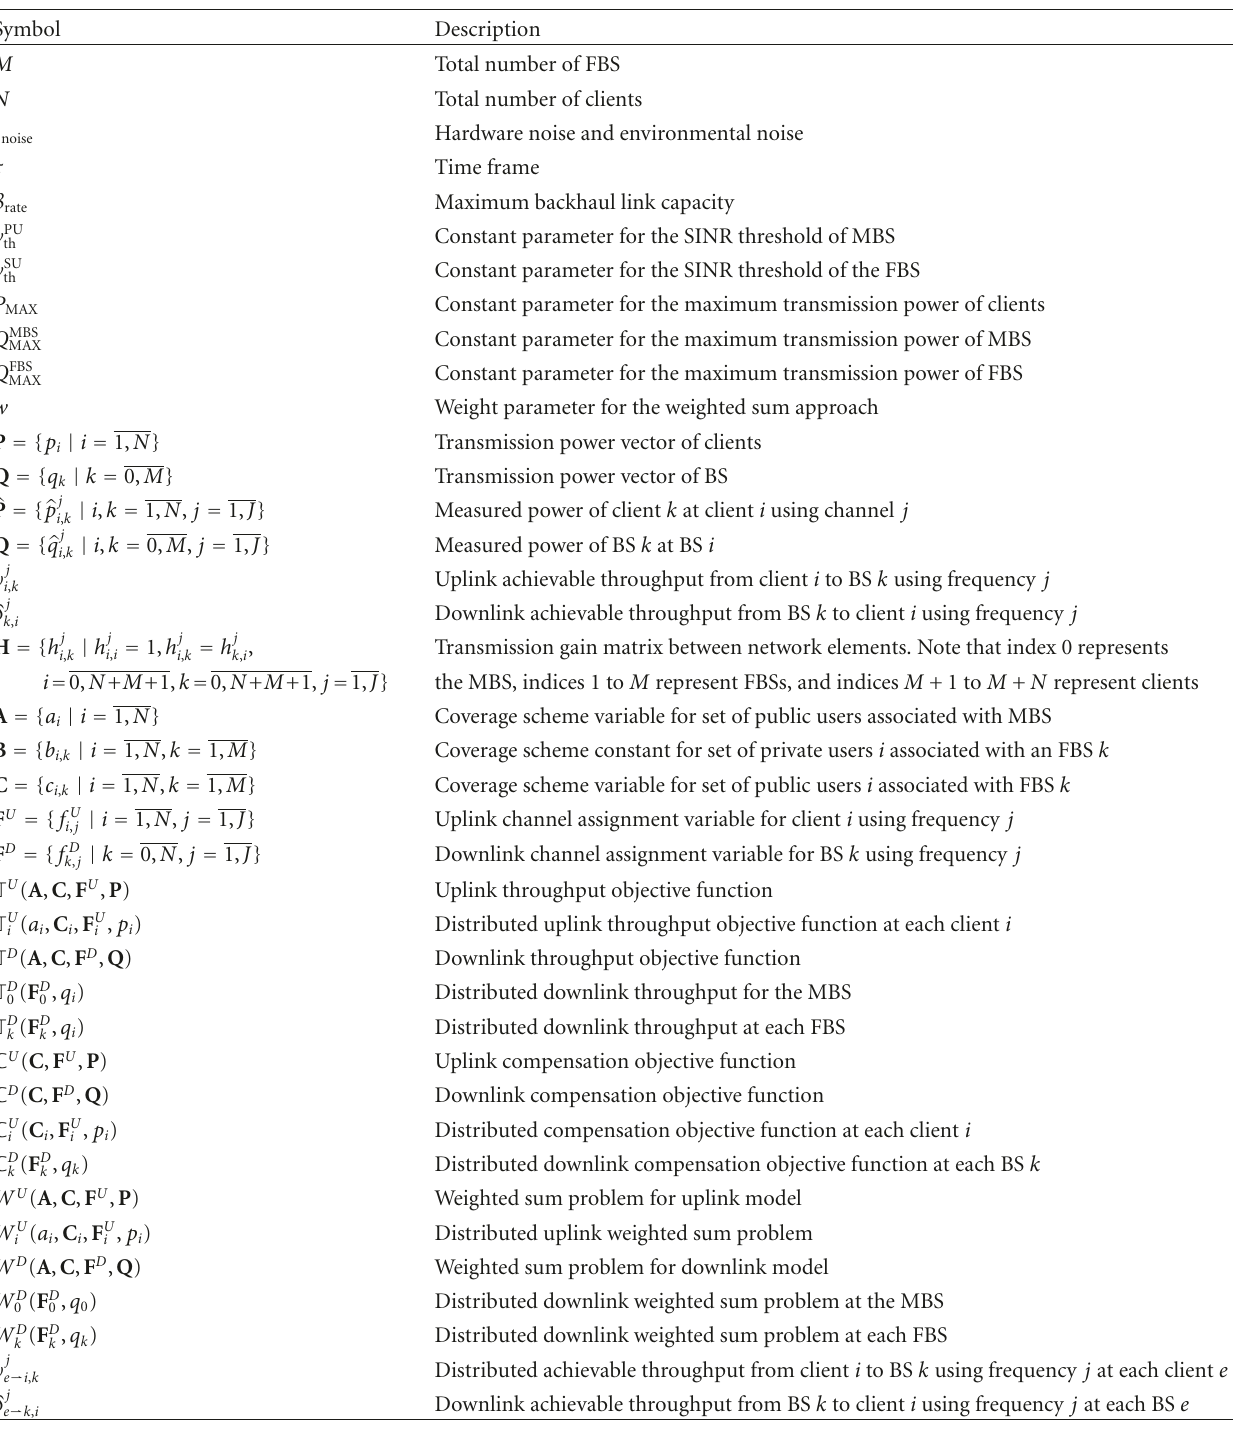
Table 1: Notation